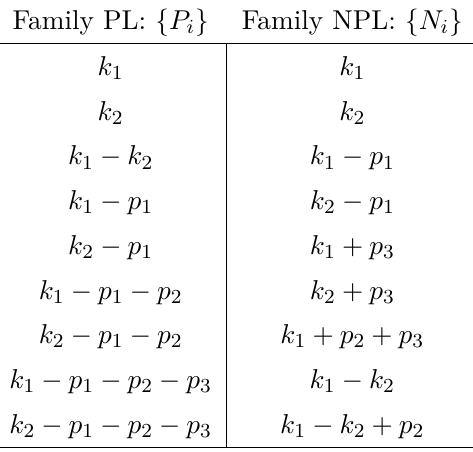
Table 1. The two auxiliary topologies of momenta which label the propagators of every diagram appearing in the amplitudes. PL labels exclusively planar diagrams, whereas NPL accommodates also all non-planar